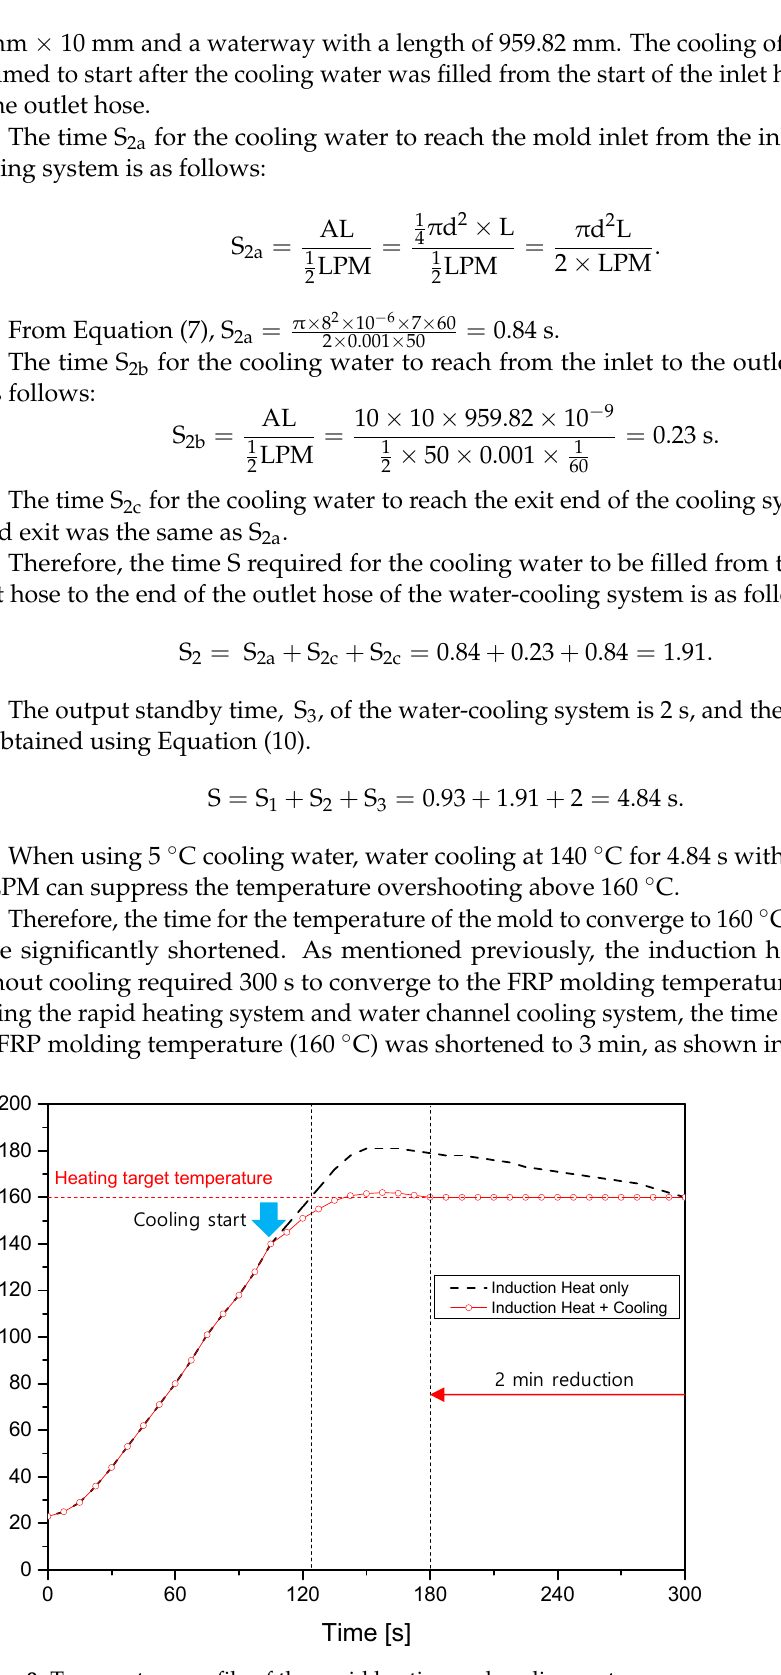
Figure 9. Temperature profile of the rapid heating and cooling system.